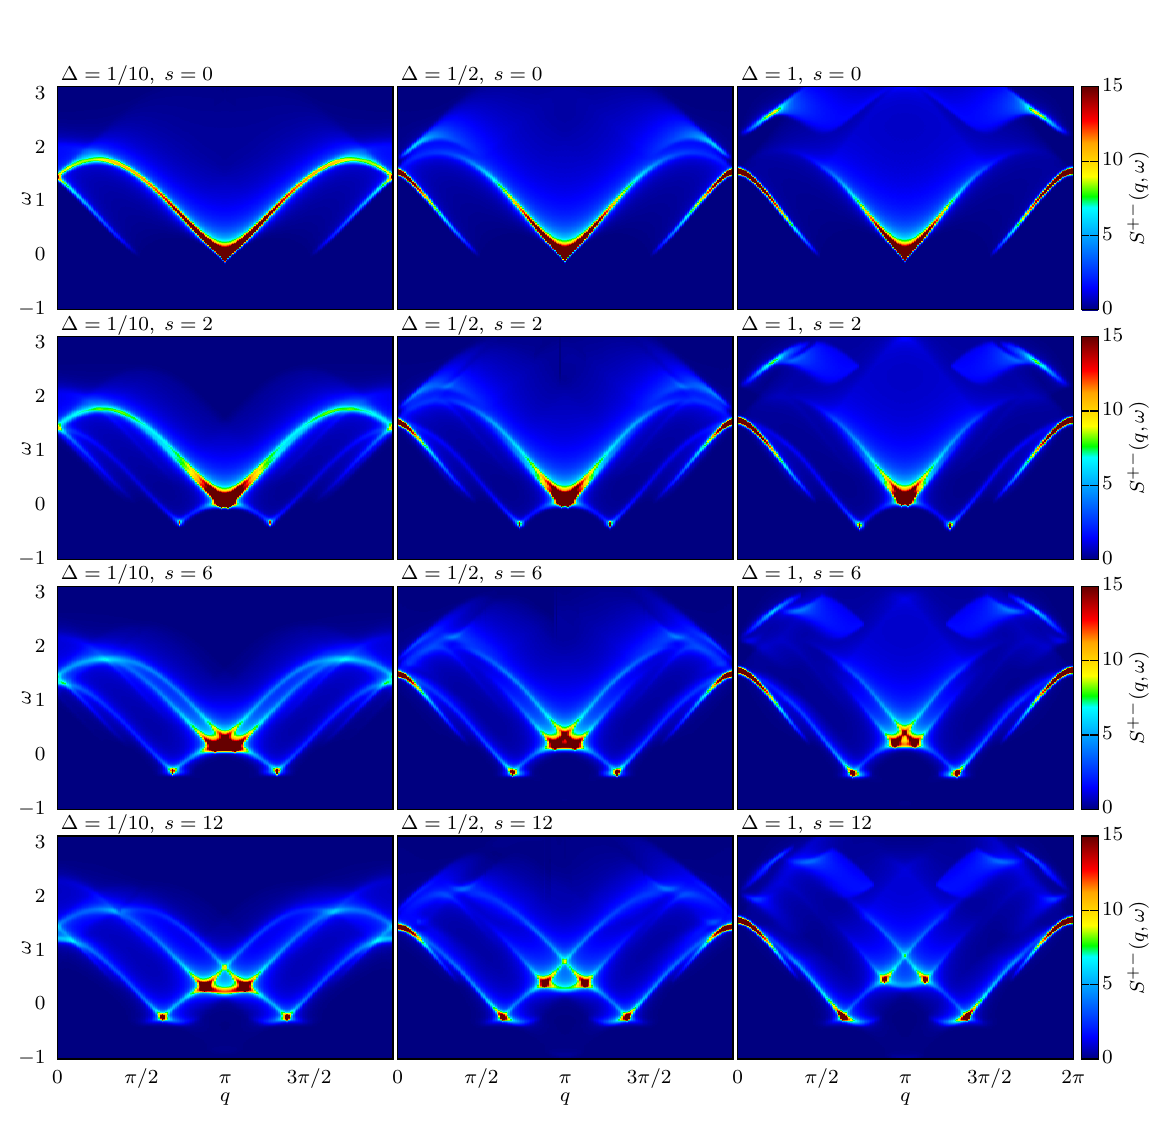
, 1 ,1. From top to 10 2